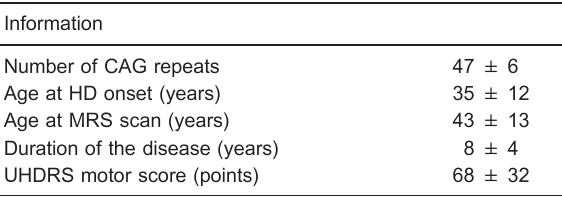
Table 1. Huntington’s disease (HD) patient clinical information.